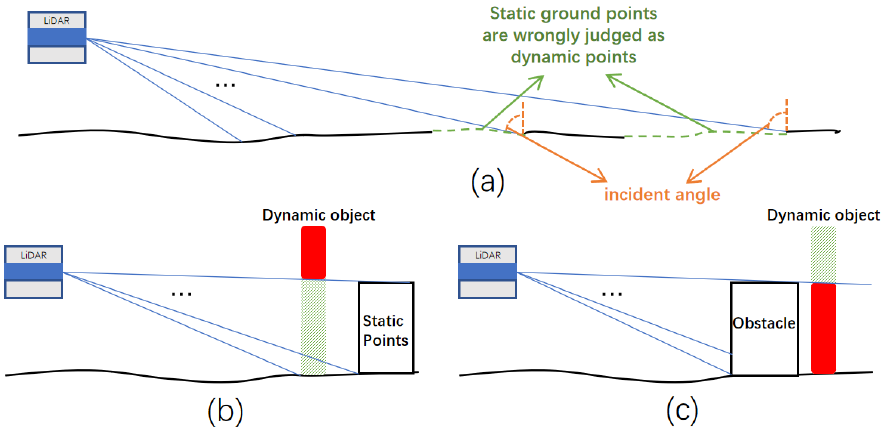
Figure 2. Shortcomings of visibility-based methods: ( a ) Ground error identification. ( b ) The red part is not removed because of the empty scene behind. ( c ) The red part is not removed because of